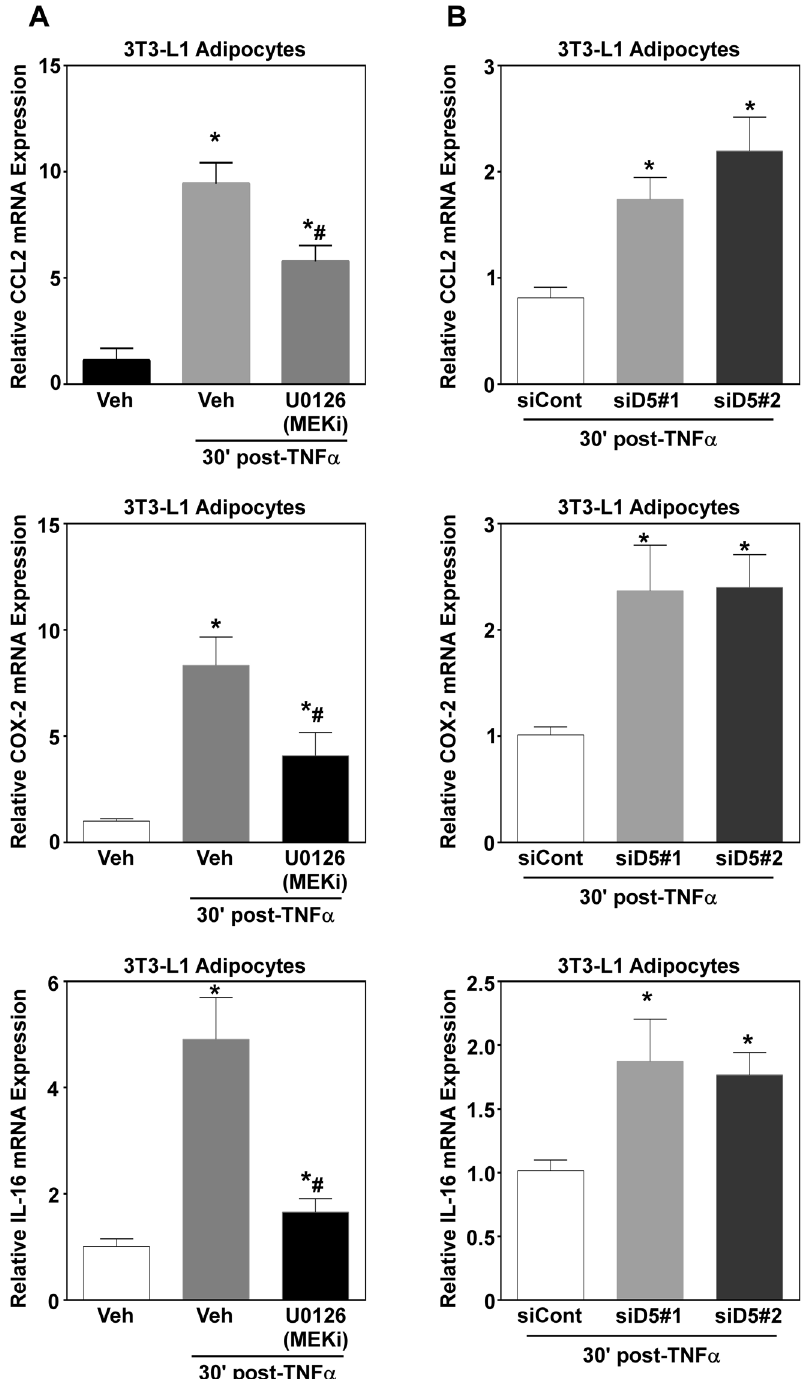
Figure 3. DUSP5 regulates ERK1/2-dependent inflammatory gene expression in adipocytes. ( A ) Adipocytes were pretreated (30 min) with the MEK1/2 inhibitor U0126 prior to stimulation with vehicle (H 2 0) or TNF α (100 pM). RNA was isolated 30 min post-TNF α stimulation and qPCR used to assess inflammatory gene expression of CCL2, COX-2, and IL-16. ( B ) Adipocytes (n = 3/group) were transiently transfected with small, non-targeting control (100 nM) siRNAs or siRNAs (100 nM) targeting independent regions of the DUSP5 gene for 48 hrs prior to stimulation with TNF α . RNA was isolated 30 min post-TNF α stimulation and assessed for CCL2, COX-2 and IL-16 mRNA expression. Statistical analysis was completed by ANOVA followed by Tukey’s post-hoc using GraphPad Prism software to determine significance p <